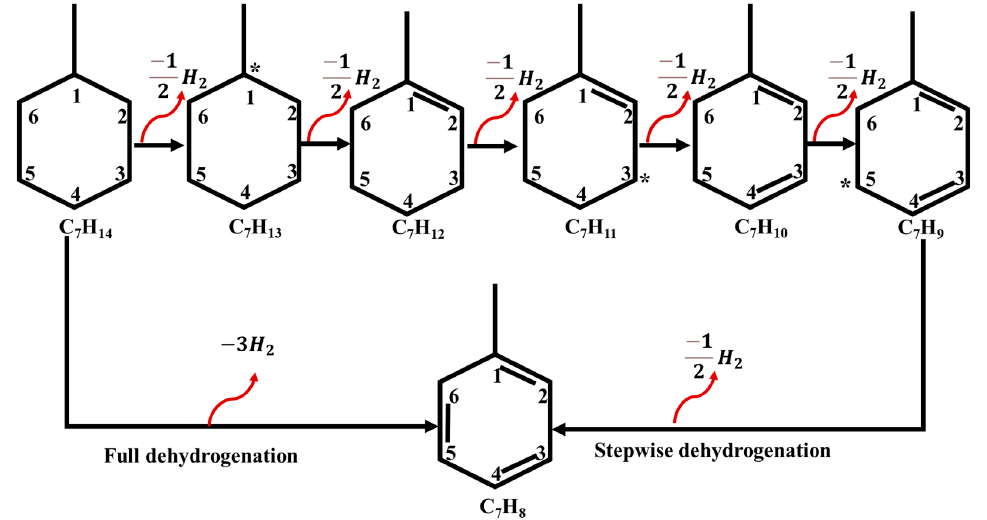
Figure 1. Full and stepwise dehydrogenation of methylcyclohexane to toluene molecule with the suggestive position of the single hydrogen atom (1/2 H 2(g) ) removal site in the molecules shown. The schematic shows that the 1/2H 2(g) removal proceeds in the order 1–6, which is an idealised configuration. The * represents removal of one 1/2 H 2(g) followed by the formation of a double C–C bond due to H 2(g) removal. The other pathways show the removal of 3H 2(g) , resulting in the full dehydrogenation of methylcyclohexane to toluene.